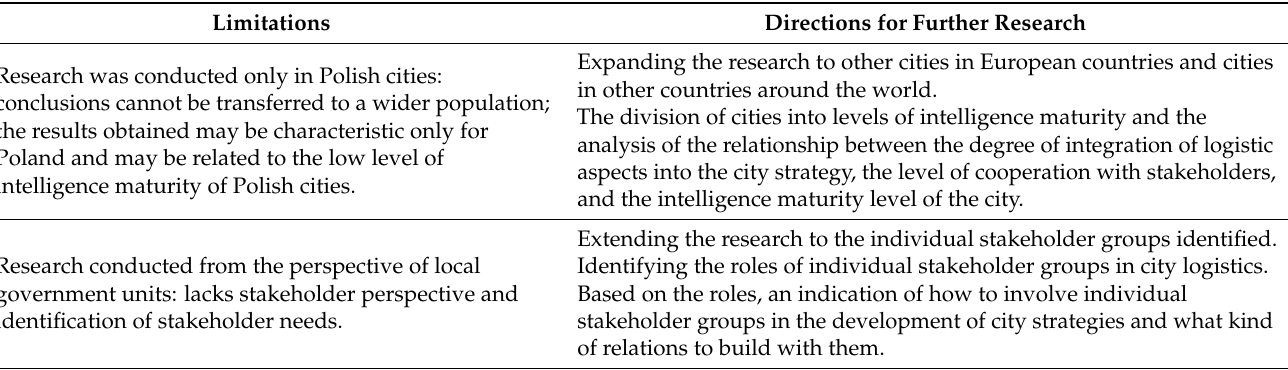
Table 5. Limitations and directions for further